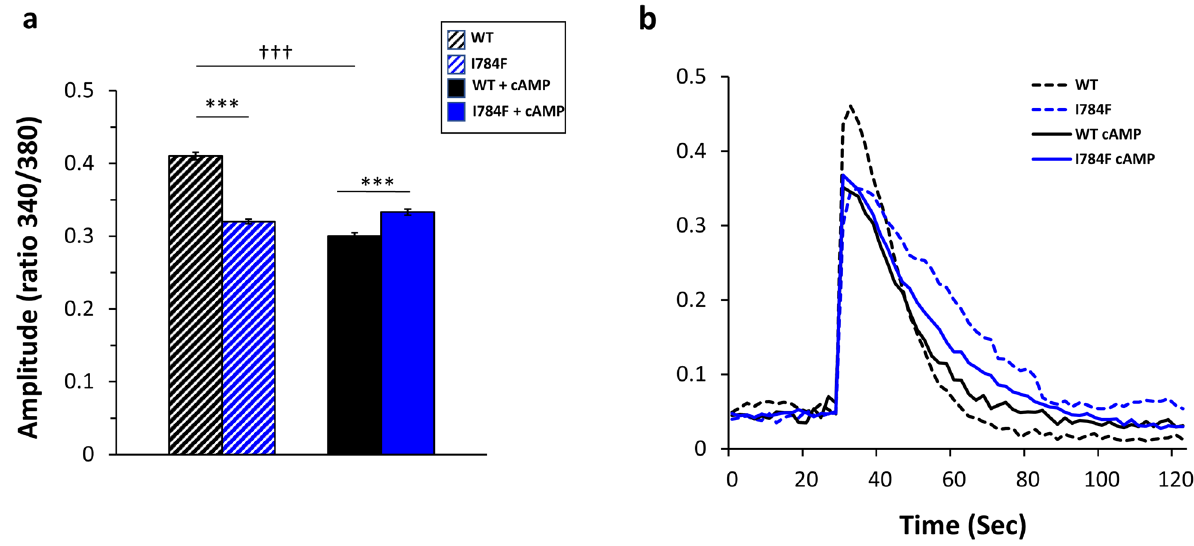
Figure 4. RyR2-I784F effect on caffeine-induced Ca 2+ release. The Ca 2+ store content was estimated by measuring the amplitude of caffeine (10 mM) induced Ca 2+ release from oscillating cells in presence of 0.5 mM of Ca 2+ . ( a ) Graphical representation of the average from all cells. ( b ) Representative plots of one cell. The total number of cells from six separate experiments were for WT n = 1578 and for I784F n = 1760; and after cAMP for WT n = 957 and for I784F n = 1007. *** p < 0.0001 for WT-RyR2 vs RyR2-I784F; ††† p < 0.0001 for basal conditions vs after cAMP